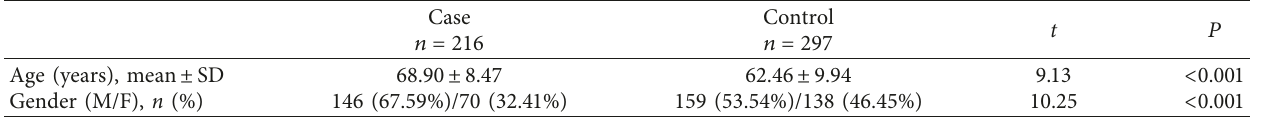
Table 1: Baseline of the two groups.